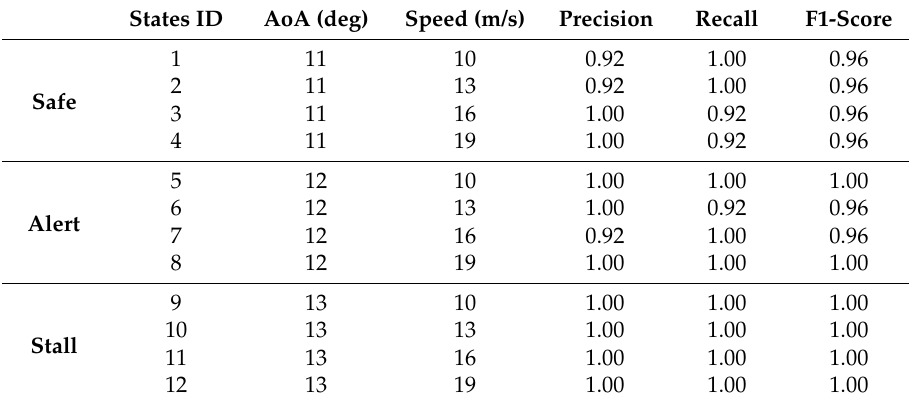
Figure 8. Identification accuracy against different feature selection methods.